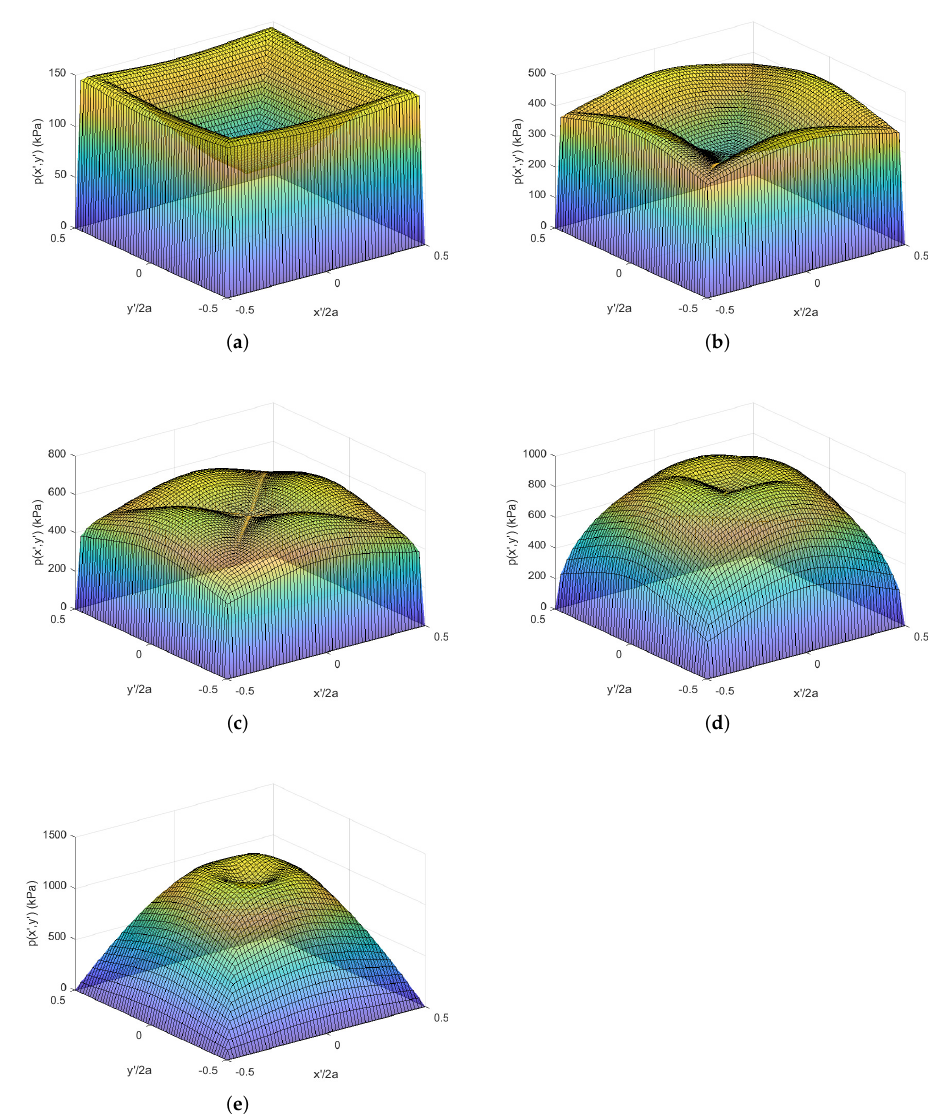
Figure 6. Normal traction surface examples mapped from Equation (1) to a square area: ( a ) Case N1; ( b ) Case N2; ( c ) Case N3; ( d ) Case N4; ( e ) Case N5.